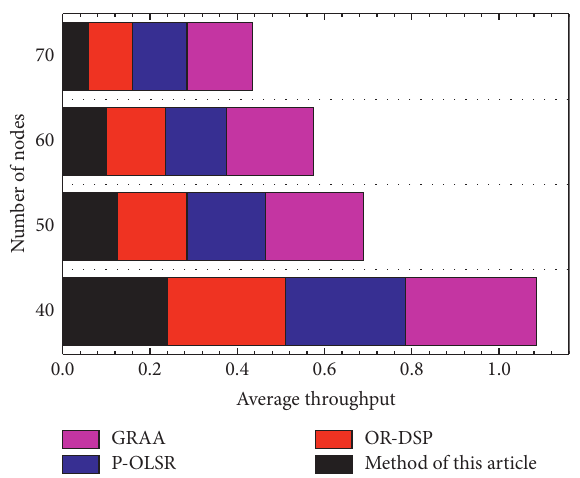
Figure 6: Packet loss rate for four routing methods with different number of